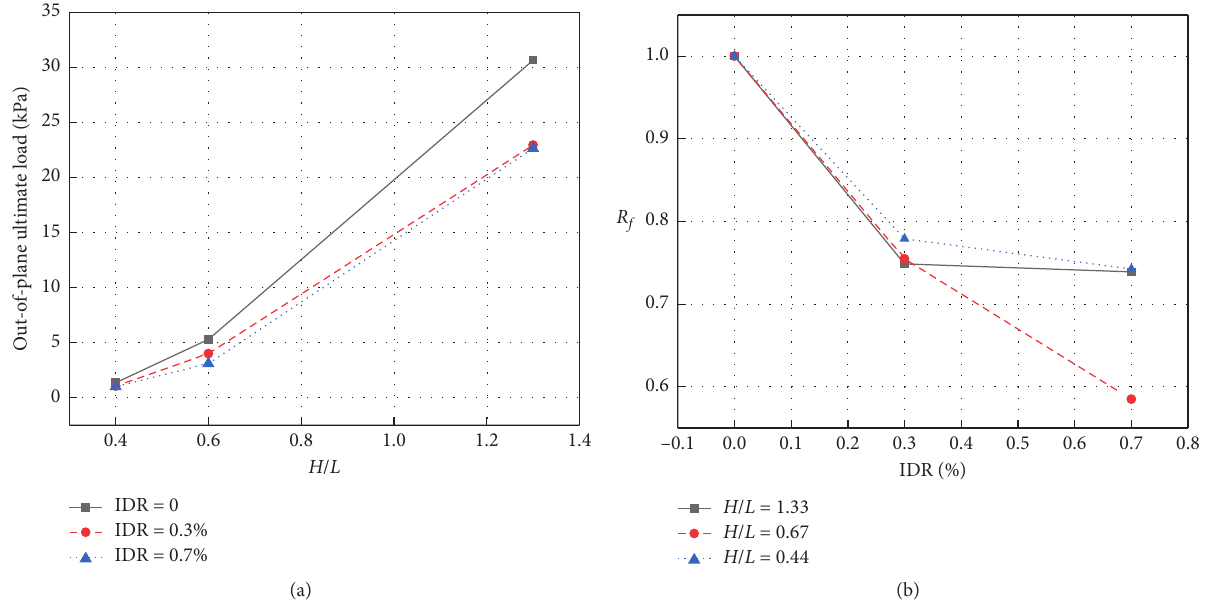
Figure 10: The effect (a) aspect ratio and (b) IP damage on the OOP strength of the infill wall.